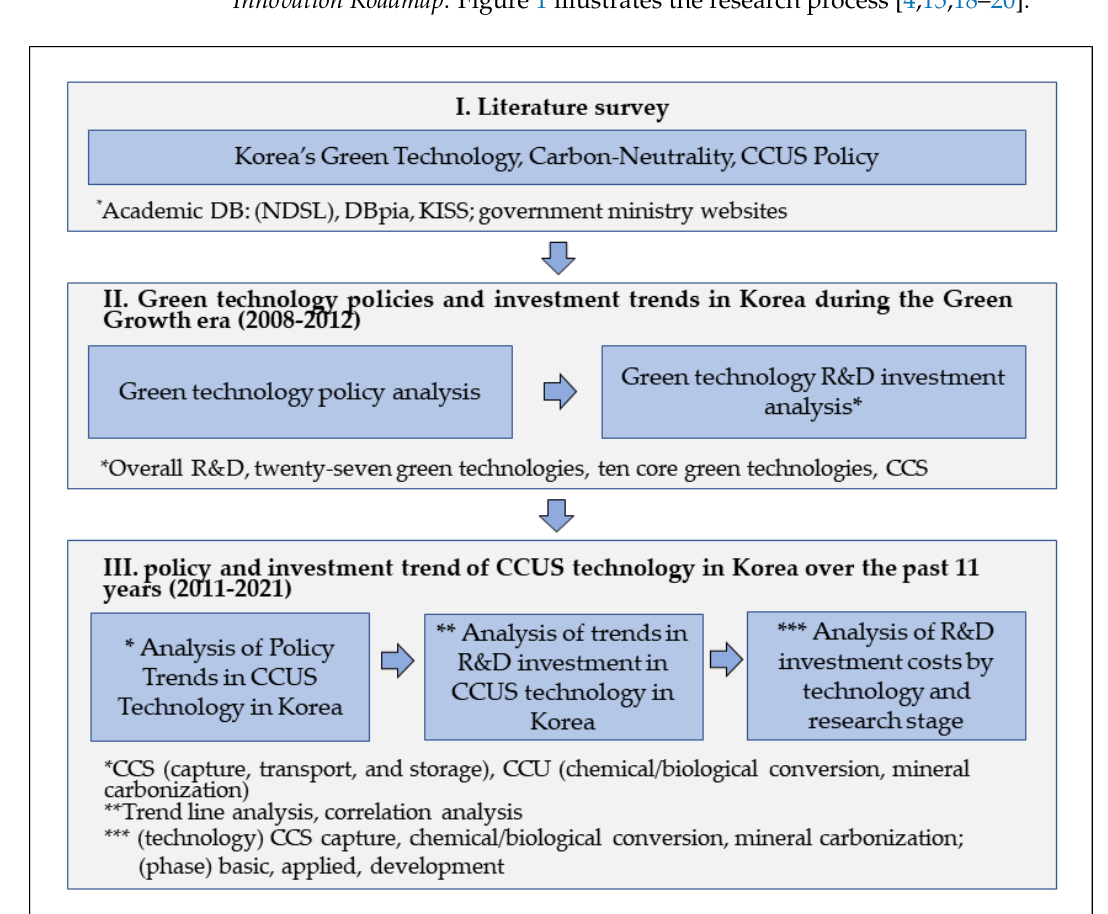
Figure 1. Research Process.